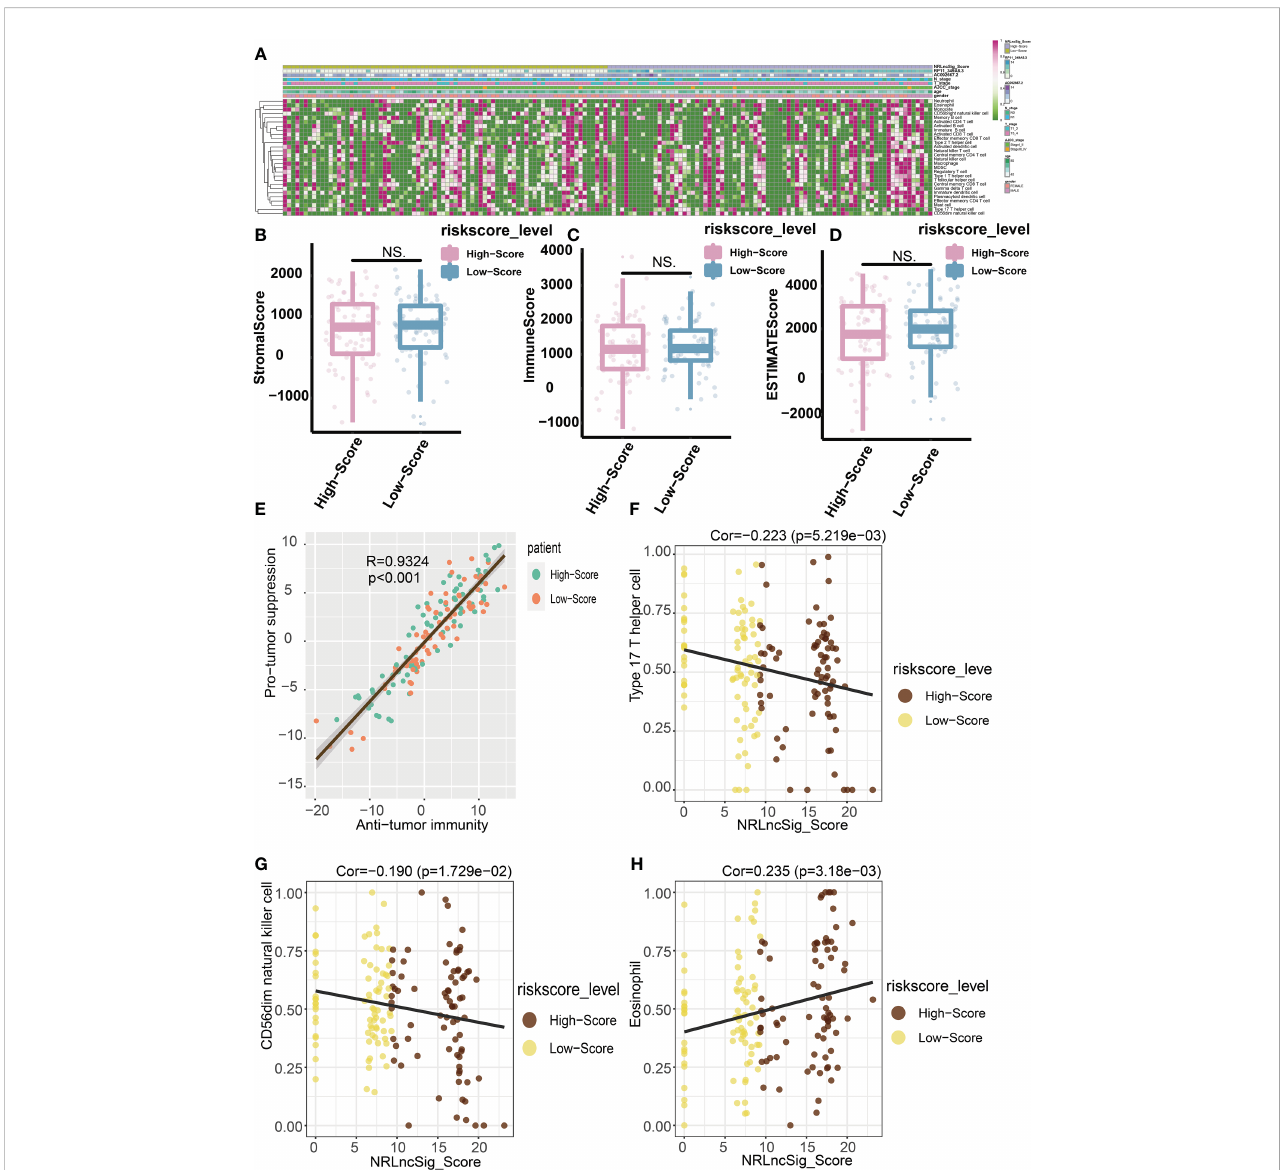
FIGURE 7 Predictive value of NRS Score for immunotherapy. (A) Relative abundance of 28 in fi ltrating immune cells. (B) StromalScore of high-score group and low- score group. (C) ImmuneScore of high-score group and low-score group. (D) ESTIMATEScore of high-score group and low-score group. (E) The abundance of immune cells with anti-tumor function and tumor-suppressor immune cells was signi fi cantly positively correlated in microenvironment classi fi ed by risk score. (F) Correlation analysis between NRS Score and Type 17 T helper cell. (G) Correlation analysis between NRS Score and CD56dim natural killer cell. (H) Correlation analysis between NRS Score and Eosinophil. NS indicates no signi fi cant